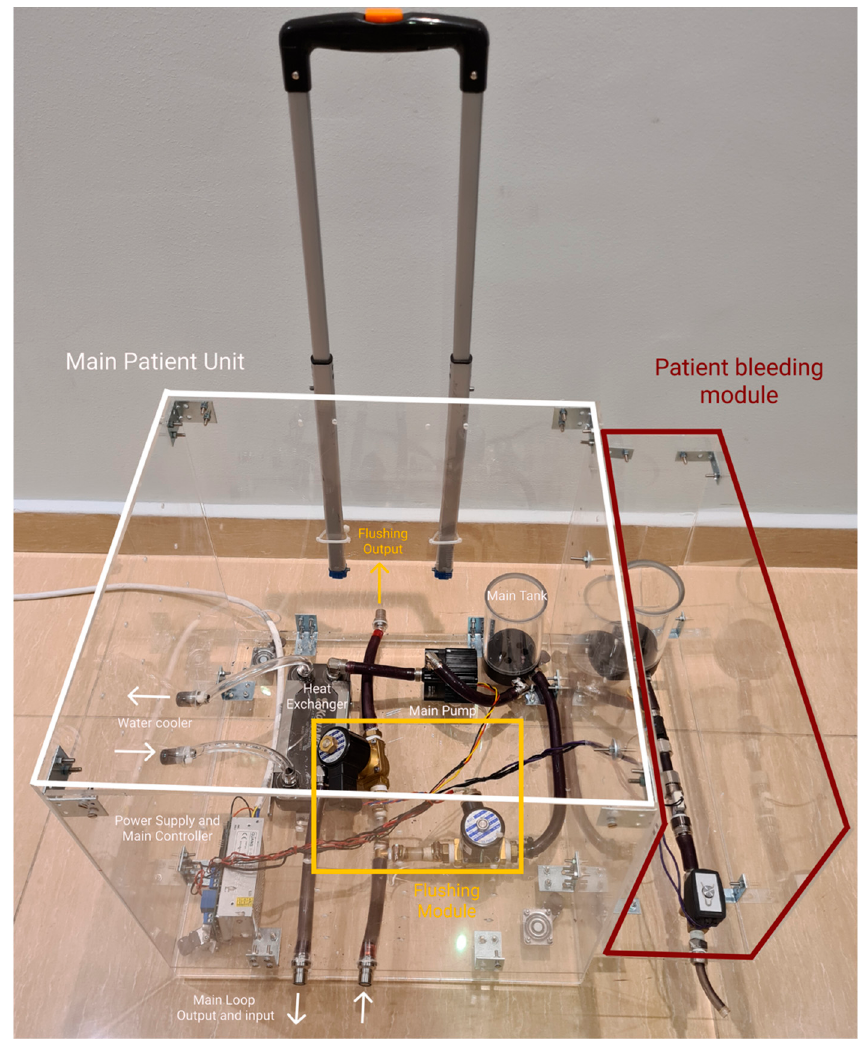
Figure 12 . Patient unit modular casing implementation with patient bleeding module. Figure 12. Patient unit modular casing implementation with patient bleeding